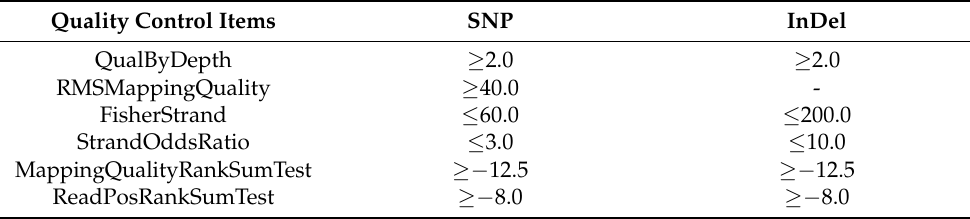
Table 2. SNP and InDel quality control